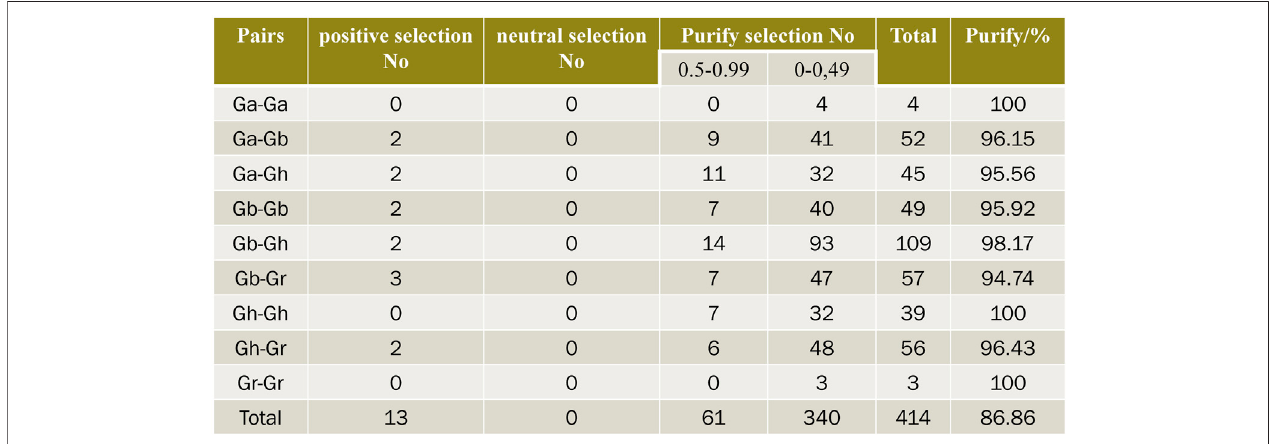
FIGURE 6 | Prediction of no of duplicated gene pairs involved in different combinations from four cotton